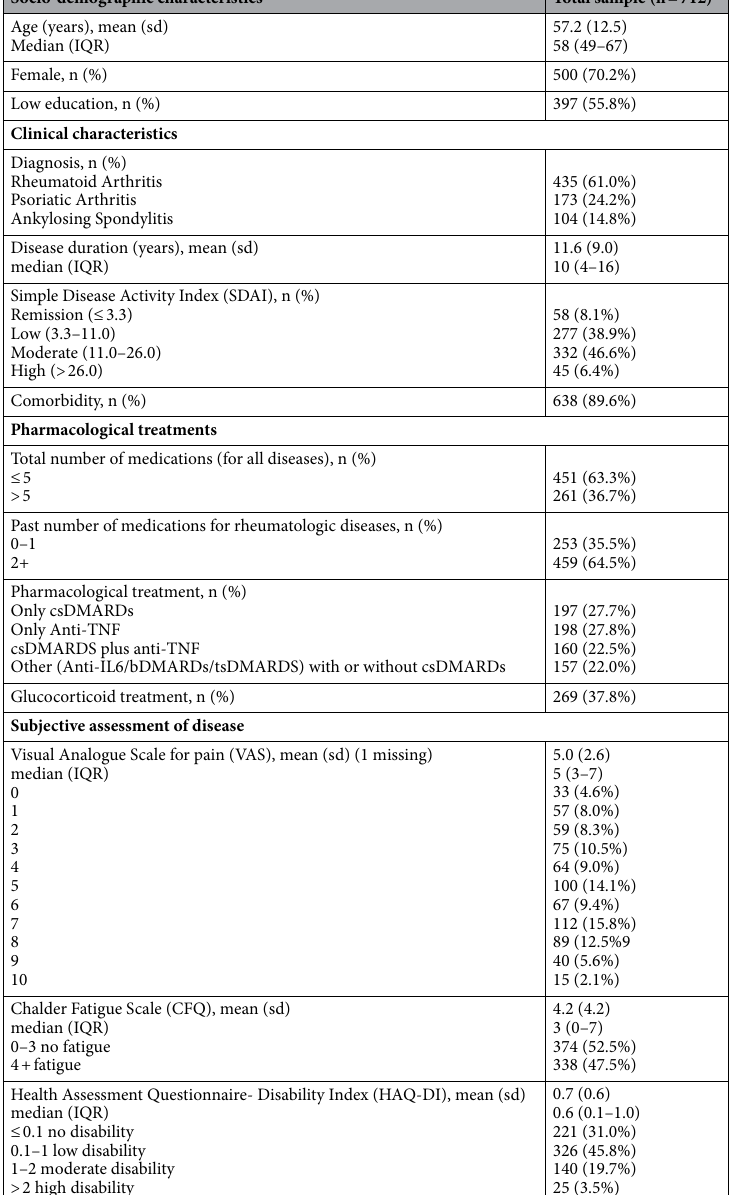
Table 1. Socio-demographic and Clinical characteristics of patients (n =